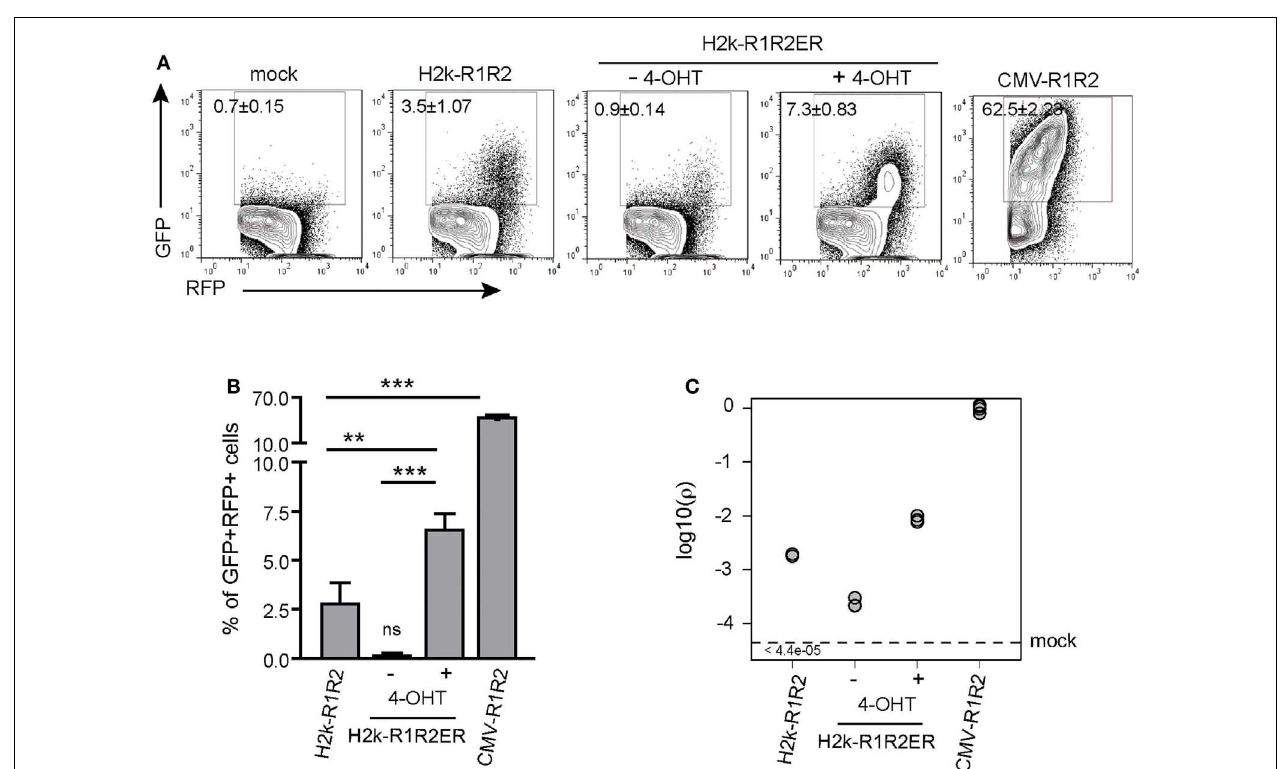
Recombination efficiency determined as [(%GFP + in test) – (%GFP + in mock)]. Mean and standard deviation of at least six replicates and at least two independent experiments. (** – p < 0.05, *** – p < 0.001, ns – not significant). (C) Relative recombination coefficient ρ when CMV-R1R2 is